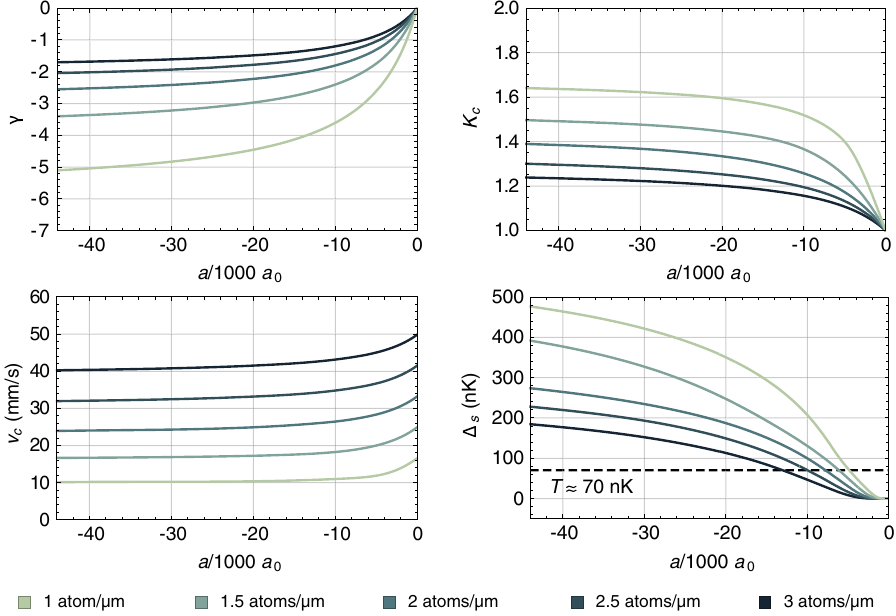
v =v , charge sector velocity v c ¼ F c